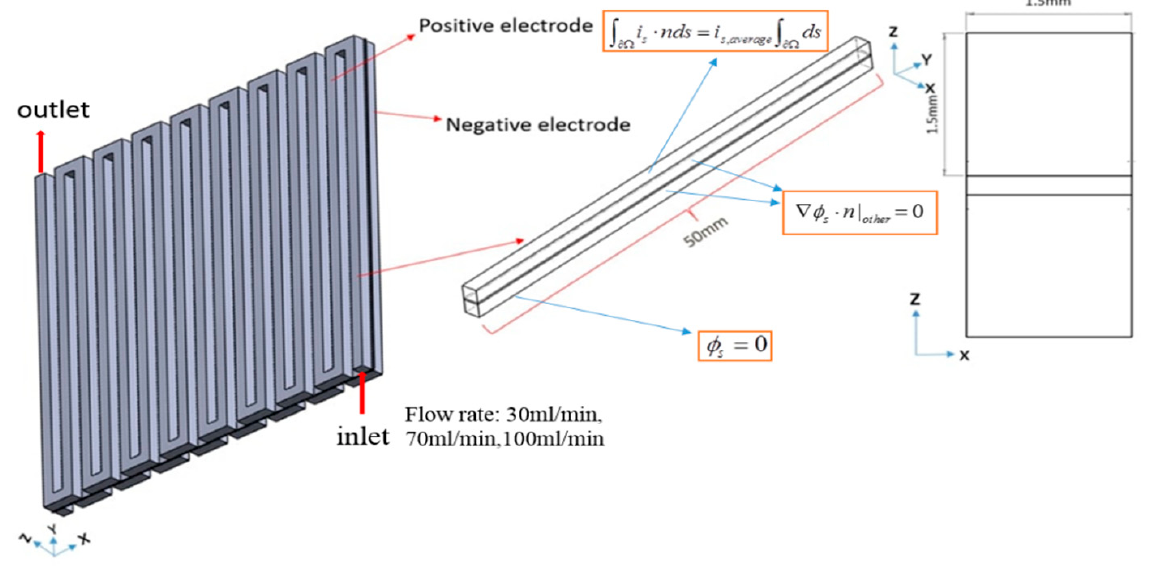
Figure 1. 3D modeling of a VRFB for serpentine flow channel.